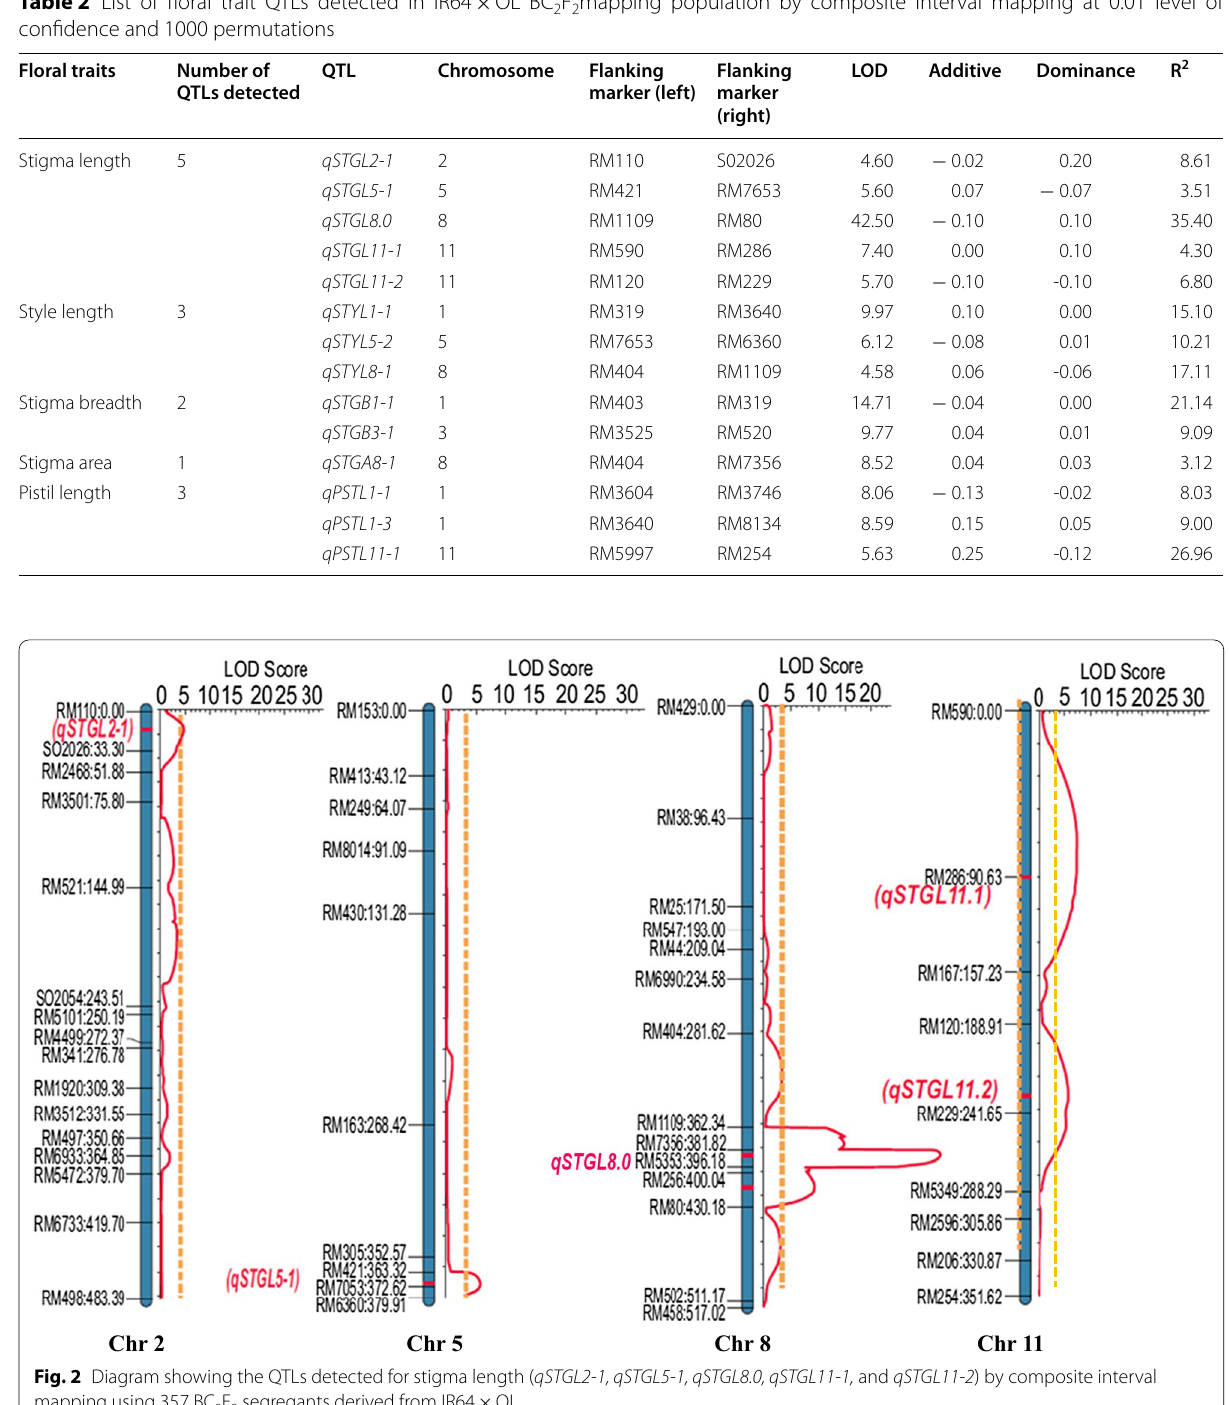
OL BC F mapping population by composite interval mapping at 0.01 level of 2 2 ×